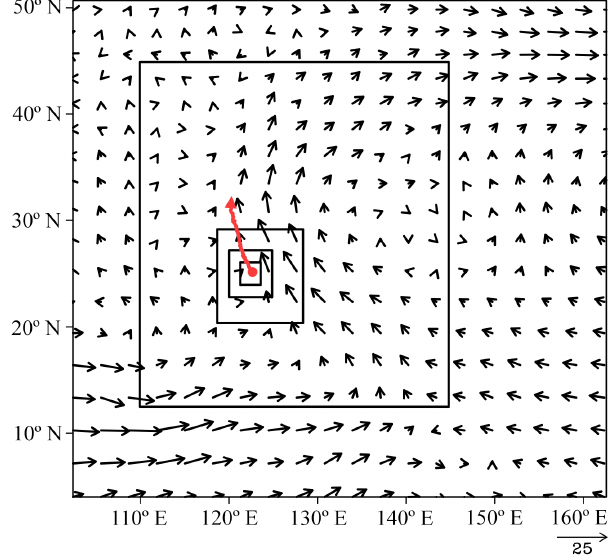
Figure 1. Model domains of the numerical experiment with the three innermost domains moving with the storm, the initial 850hPa wind (ms − 1 ) field (vectors) and the simulated tropical cyclone track